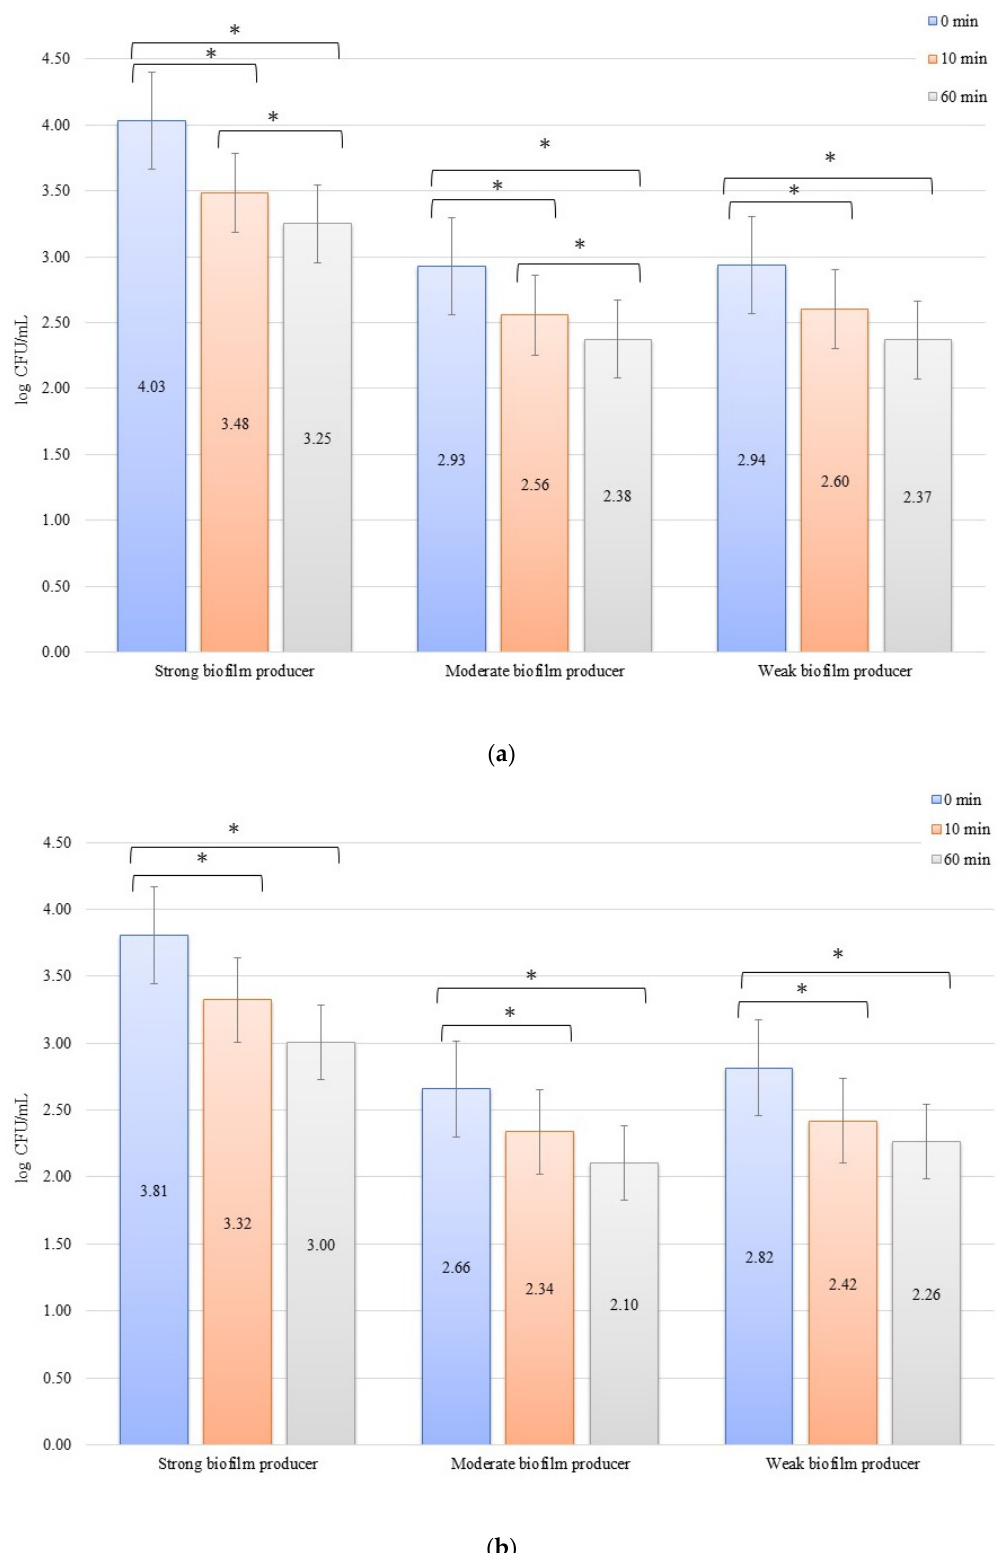
Figure 2. Biofilm inhibition assay for Staphylococcus aureus . Strains forming biofilms on Ti-6Al-4V ( a ) and zirconium dioxide ( b ) discs classified as strong, moderate, weak, and non-producers are treated using low direct electric currents 10 mA. Error bars represent the pooled standard deviations of the mean. The level of significance is presented at * p < 0.05. The mean and standard deviations are